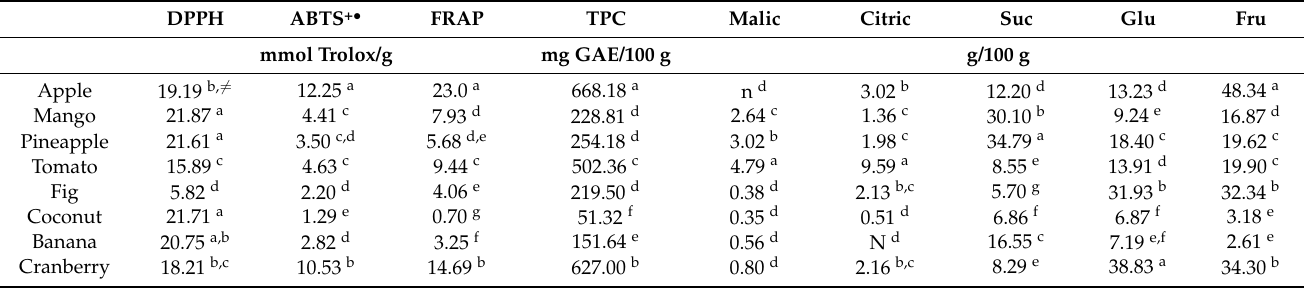
Table 3. Antioxidant capacity, total phenols, and organic and sugar profile.